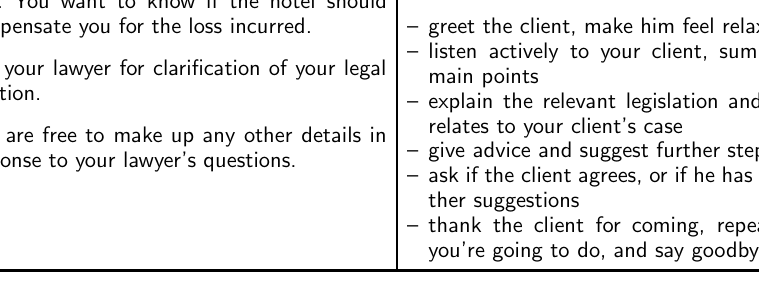
Figure 1. Example of an effective mediation practice